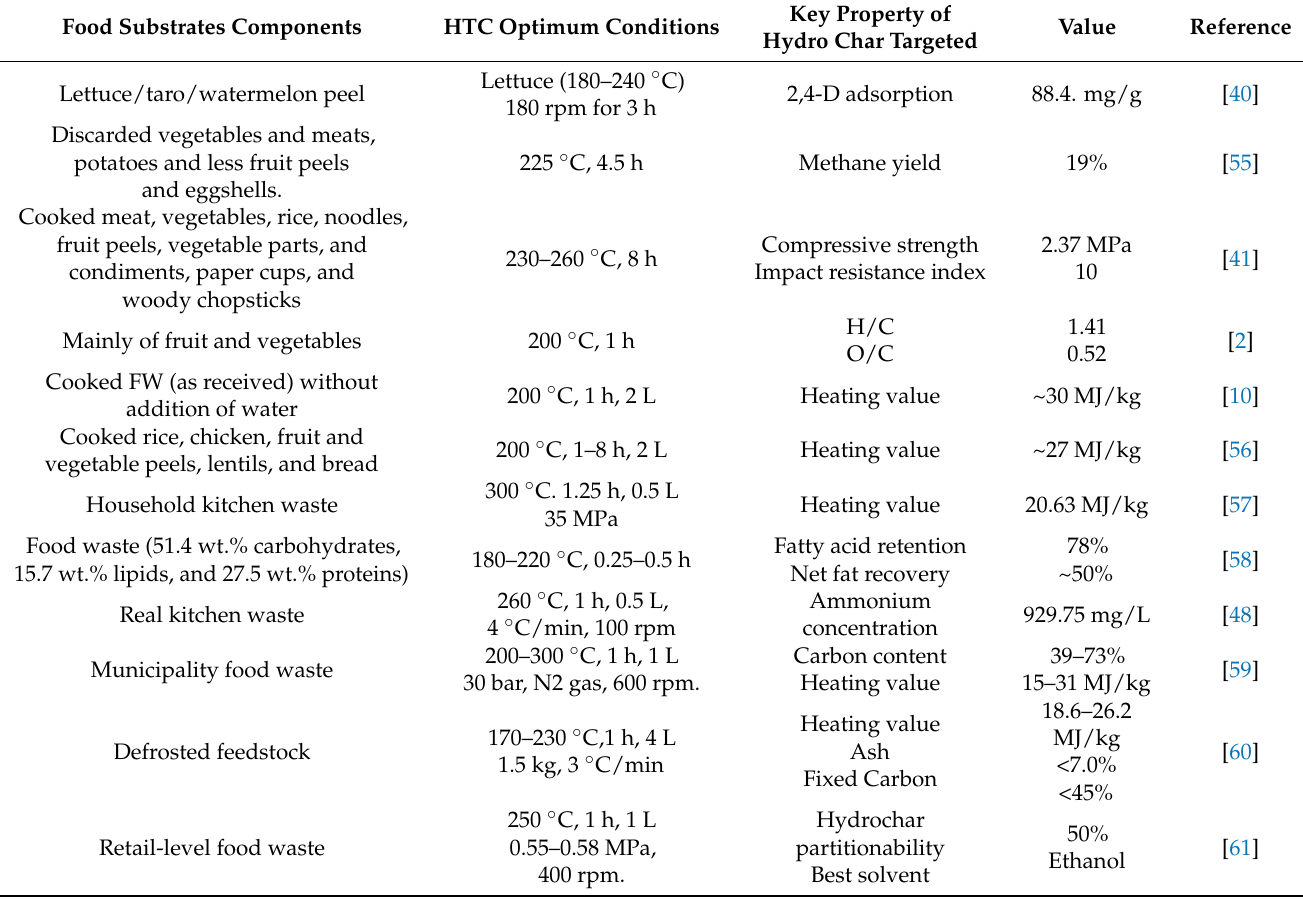
Table 2. Properties of hydrochar developed from HTC of food waste under optimum